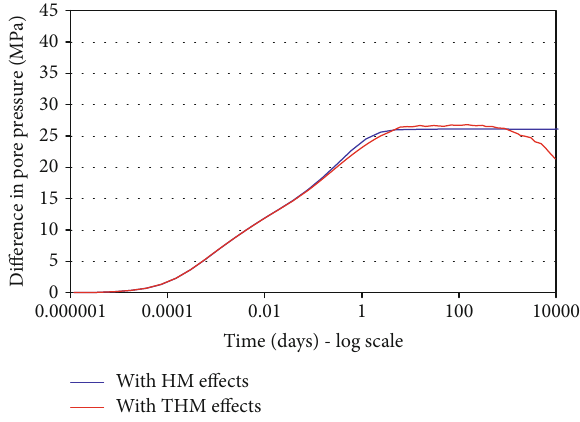
Figure 9: Variation with time of the di ff erence in the fl uid pore pressure between the injection and production boreholes, obtained with consideration of hydromechanical (HM) and thermo-hydro-mechanical (THM) e ff ects.